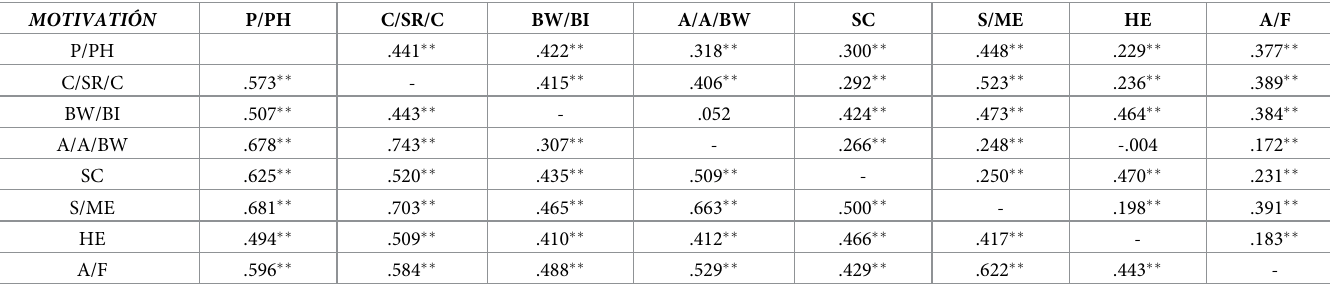
Table 3. Correlations for preadolescents and adolescents in motivation towards the practice of physical exercise.